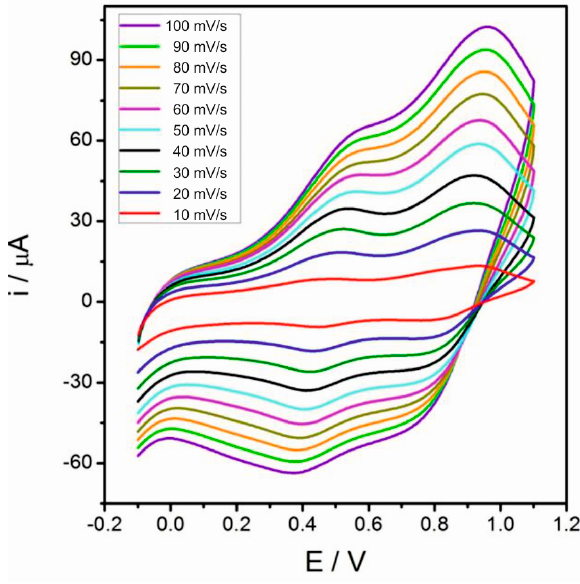
Figure 3. Cyclic voltammograms of manganese oxide MnO x ) ‐ LS at various scan rates in supporting electrolyte (Na 2 SO 4 ).